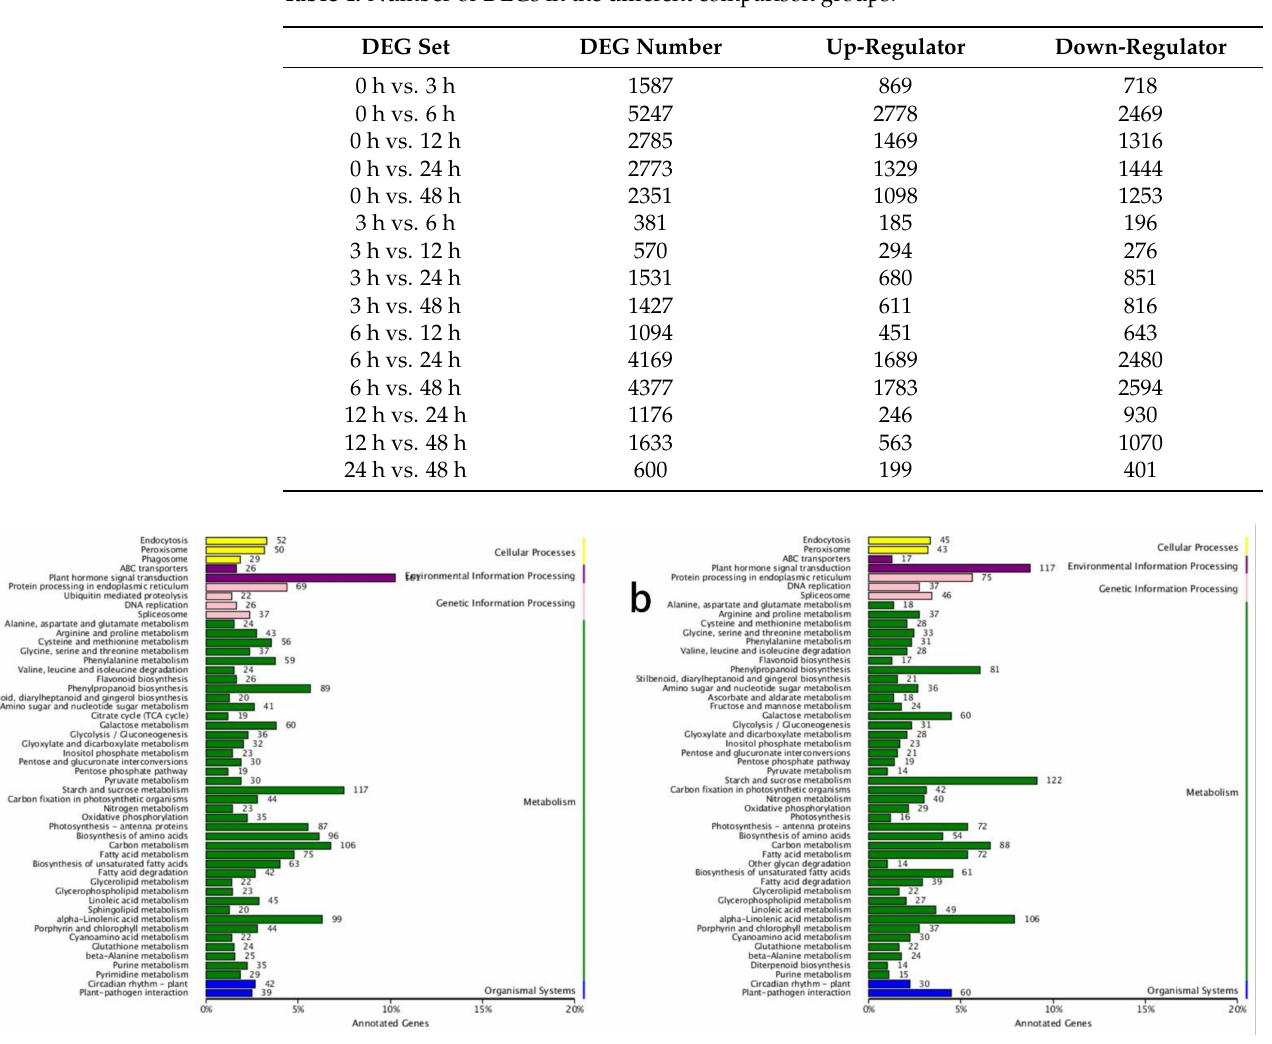
Table 4. Number of DEGs in the different comparison groups.